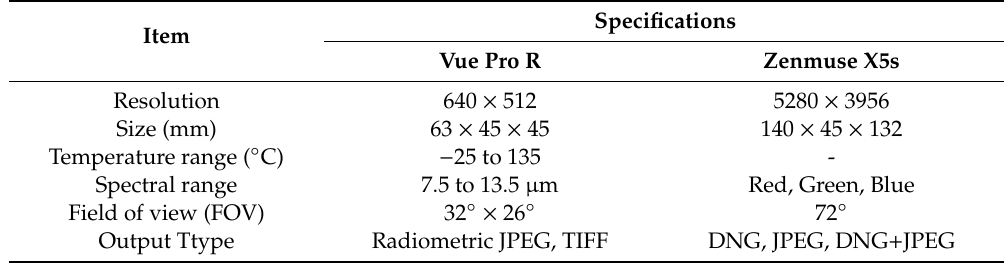
Figure 2. The image ( a ) shows the optical sensor and the thermal infrared sensor mounted on the Inspire 2, ( b ) the optical sensor (Zenmuse X5s), and ( c ) the thermal infrared sensor (Vue Pro R). Table 2. Specifications of optical and thermal infrared Table 2. Specifications of optical and thermal infrared sensors.